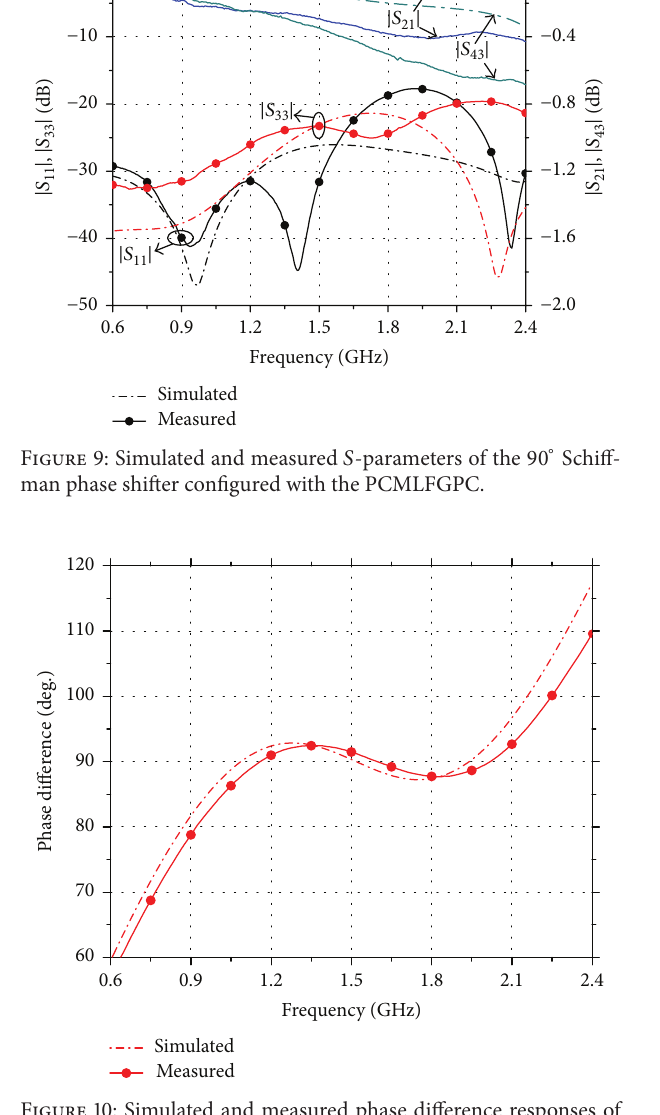
Figure 10: Simulated and measured phase difference responses of the 90 ∘ Schiffman phase shifter configured with the PCMLFGPC.